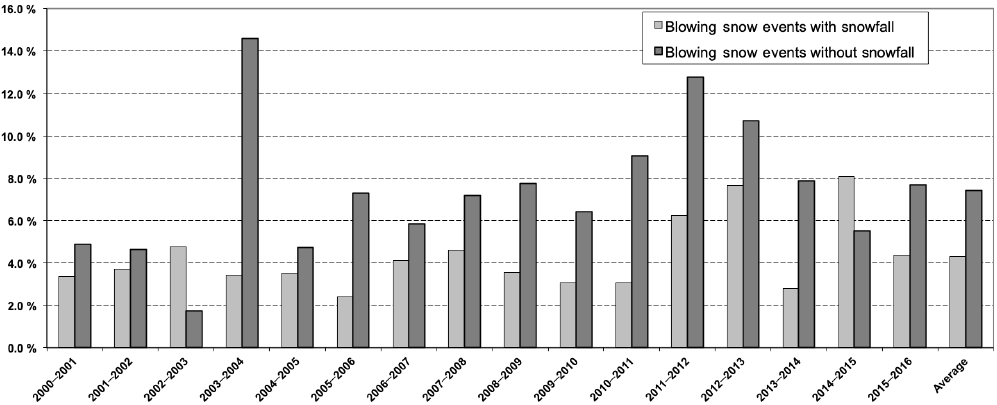
Figure 3. Percentage of time when blowing snow events (with and without snowfall) are recorded for each winter (1 December to 31 March) over the period 2000–2016 at the Col du Lac Blanc experimental